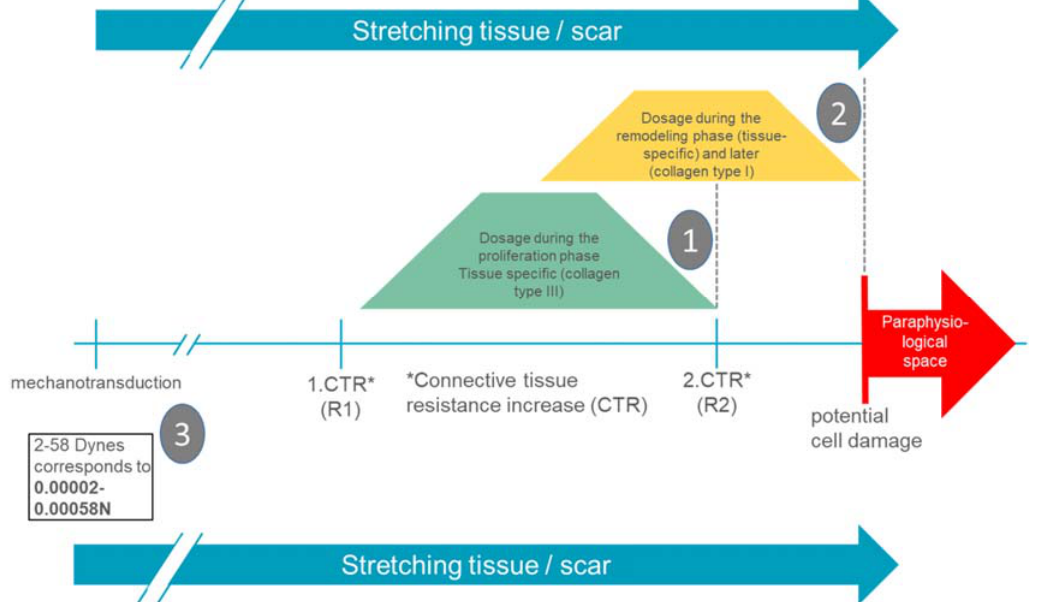
Figure 7. Summarizing presentation of wound ‐ healing phase adapted and tissue ‐ specific dosages in manual therapy of injured tissue (post ‐ traumatic/postoperative) (source: own presentation). Legend: